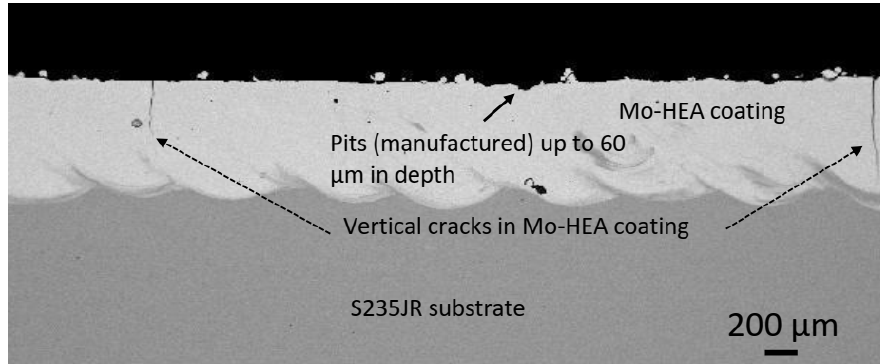
Figure 2. Unexposed sample Mo-HEA-S235JR.Vertical cracks were observed in the Mo-HEA coating on substrate S235JR, and variance on the coating surface, in the form of pits, was also observed.